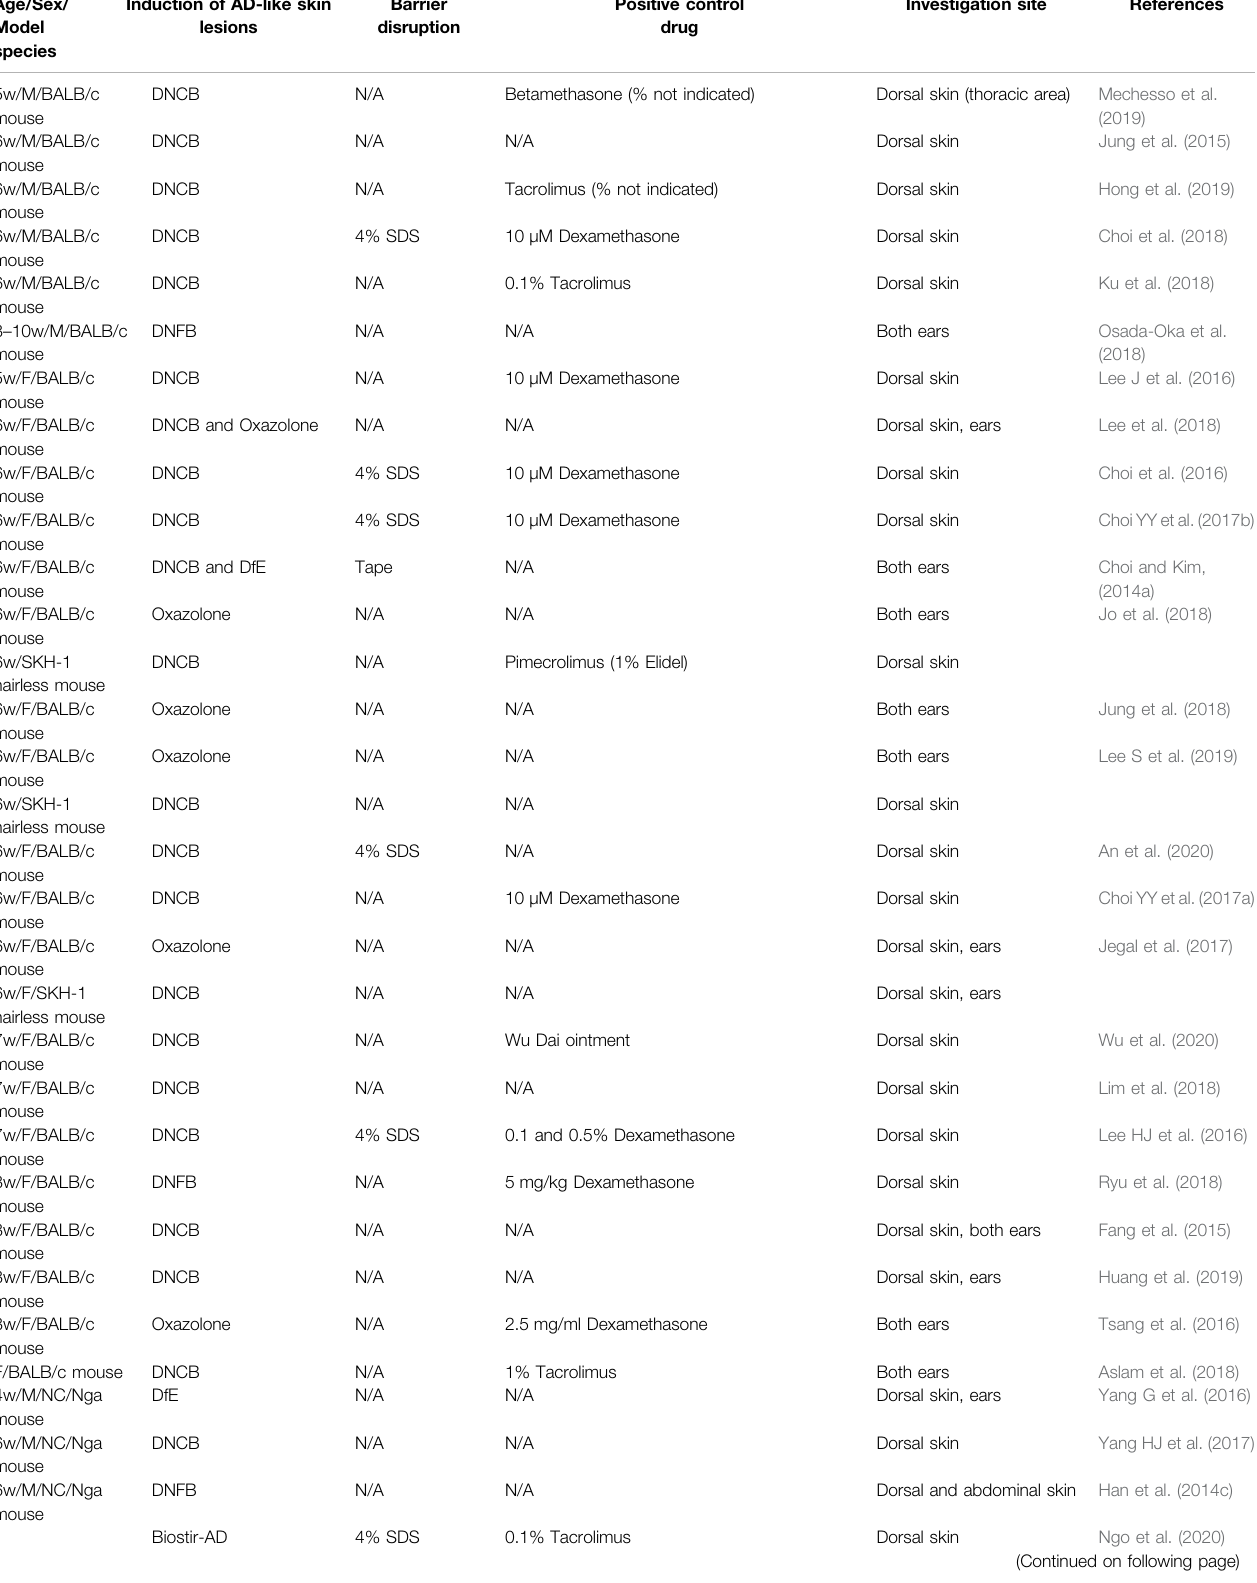
TABLE 3 | Basic characteristics of the murine models and experimental procedures from studies involving topical treatments of herbs and their active